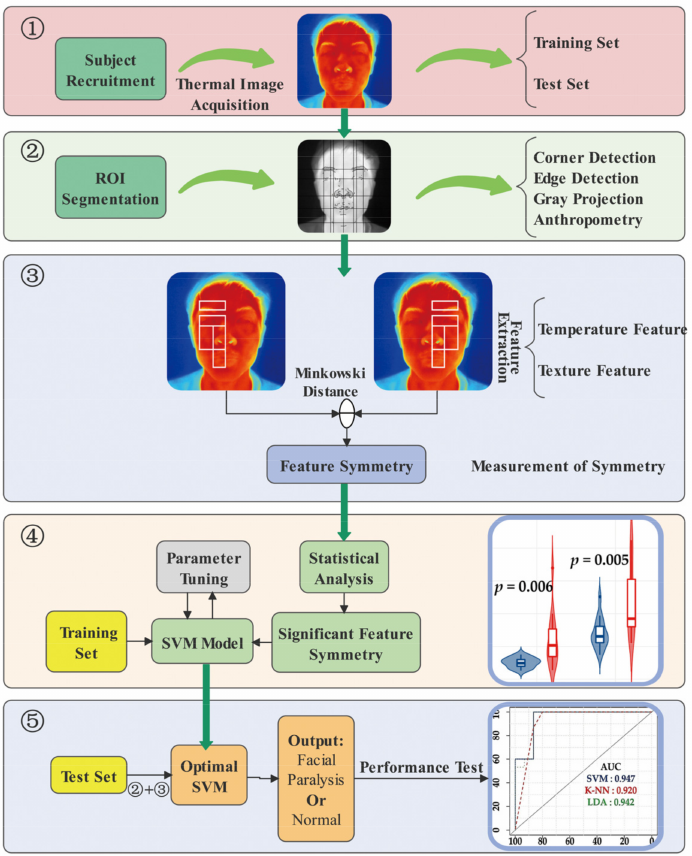
Figure 1. Overview of proposed classification method for early detection of facial